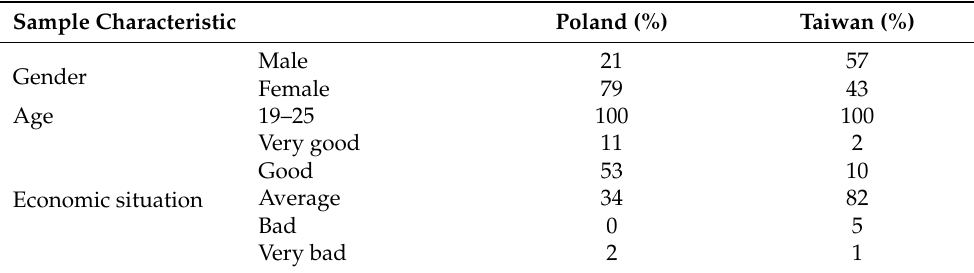
Table 1. Sample characteristics ( n = 200).